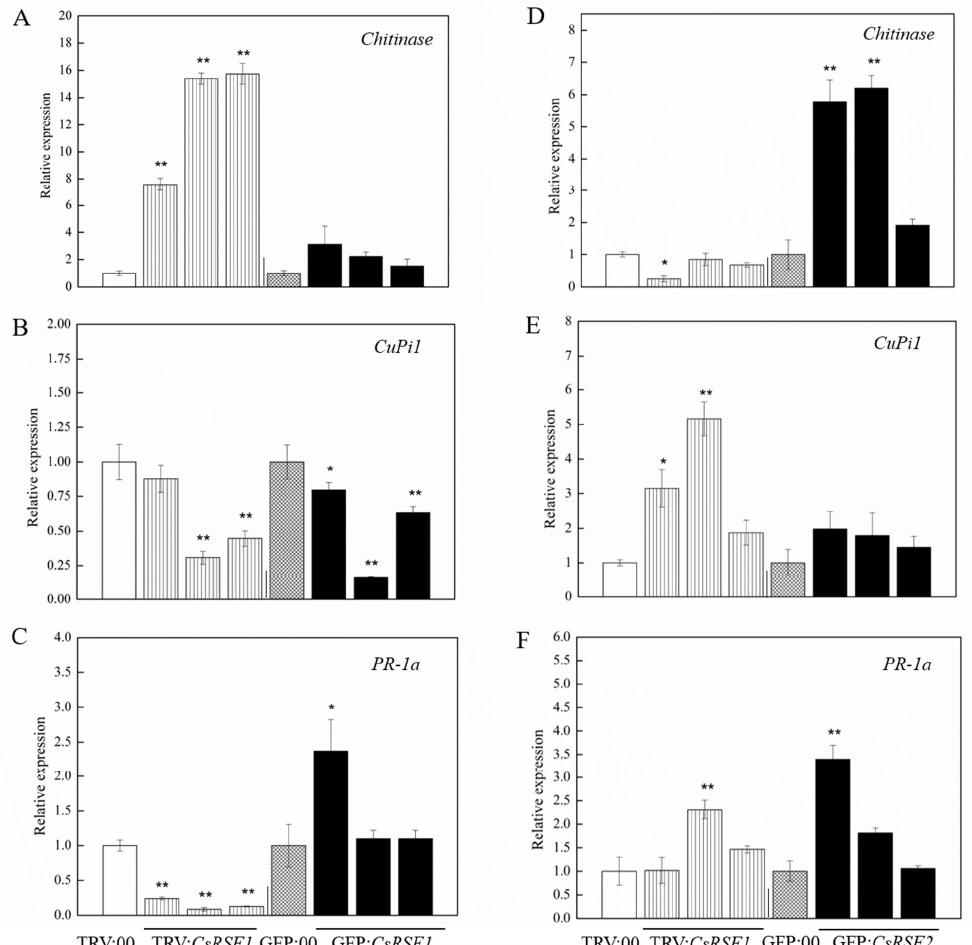
Figure 9. CsRSF1 and CsRSF2 -mediated expression patterns of defense-related genes ( Chitinase , CuPi1 , PR-1a ) in transient silencing (TRV) and overexpressing (GFP) cucumber cotyledons. ( A – C ) The relative expression of Chitinase , CuPi1 , PR-1a in CsRSF1 -transient silencing and overexpressing cucumber cotyledons. ( D – F ) The relative expression of Chitinase , CuPi1 , PR-1a in CsRSF2 -transient silencing and overexpressing cucumber cotyledons. Data are means ± standard (SD) deviations from three independent experiments, and each column represents a sample containing three cucumber cotyledons from different plants. Expression analysis of candidate genes using the 2 − ∆∆ C t method. The asterisks indicated a significant difference (Student’s t -test, * p < 0.05 or ** p <